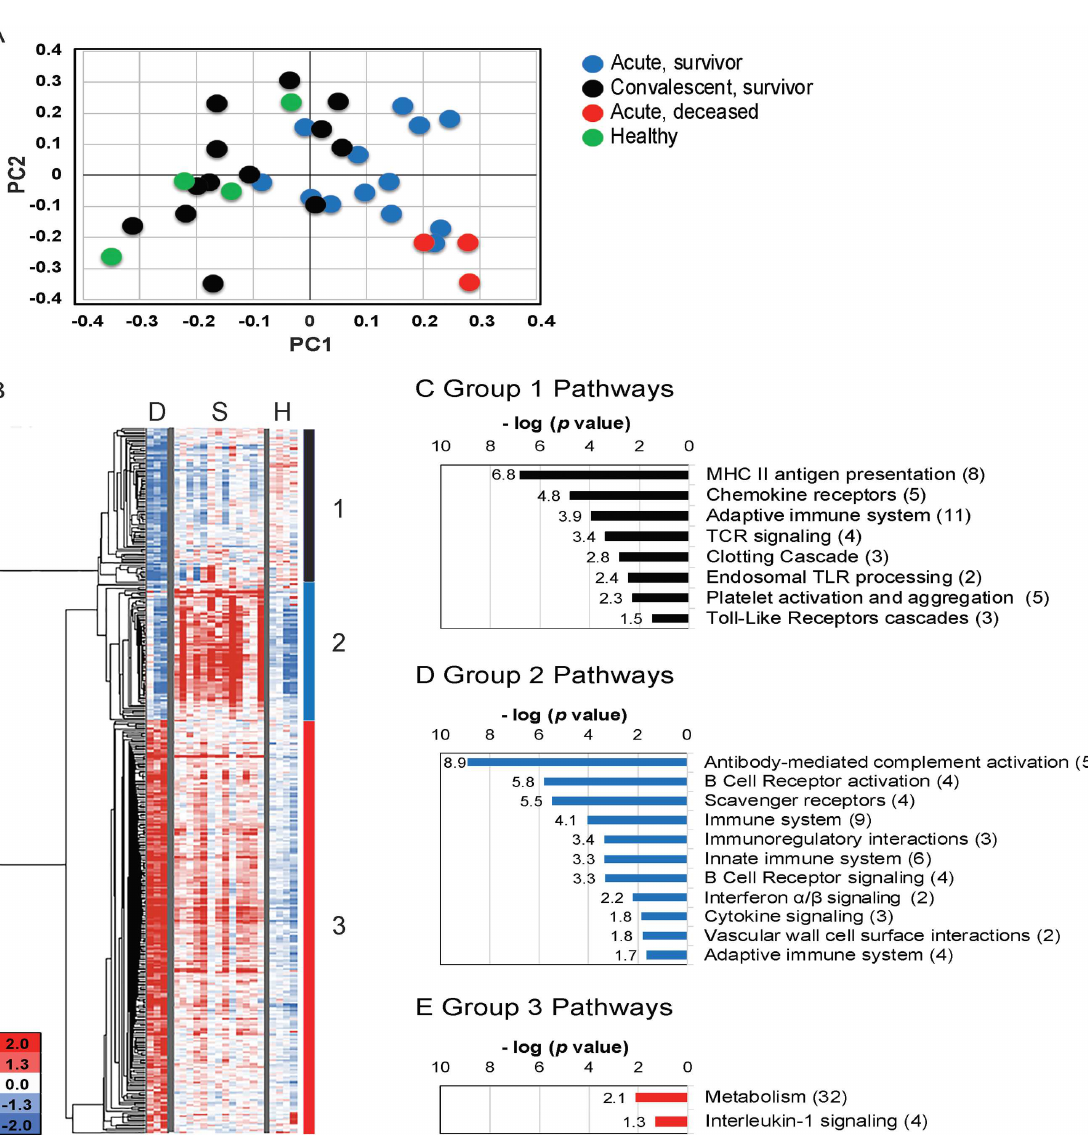
Fig 1. Transcriptional signatures associated with fatal cases. (A) PCA of all probes for 3 patient groups and healthy volunteers. (B) Heatmap depictinghierarchicalclustering of 471 probes with differentialexpressionduring acute illness in 3 deceasedpatients (D) and 13 acute survivors (S). For comparison, the same transcripts for 4 healthy volunteersare shown (H). Blue indicates down-regulation and Red indicates up-regulation in log 2 . (C-E) Functional REACTOME pathways for 3 expression groups with negative log of p-values and number of genes in parentheses. In Groups 1 (black box) and 2 (blue box), transcripts were enriched in survivors vs fatal cases, while in Group 3 (red box), transcripts were enrichedin fatal